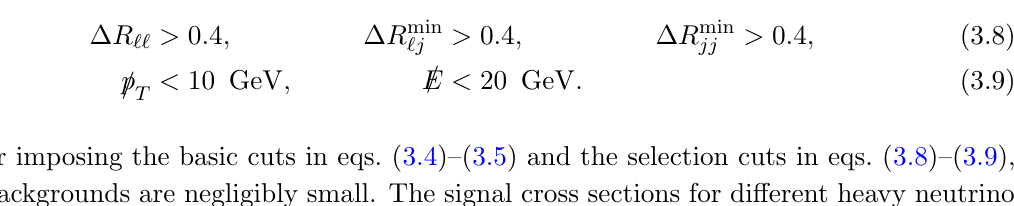
Figure 5 . Normalized distributions (cid:27) (cid:0) 1 d (cid:27)= d X for background channel e (cid:0) e + ! W + Z +4 j; W + ! (cid:22) + + (cid:23) (cid:22) ; Z ! (cid:22) (cid:0) (cid:22) + at the CEPC for the missing transverse momentum =p momentum =p and missing total energy =E . The missing total energy is the c.m. energy 250 GeV L minus the sum of energies of all visible particles in the (cid:12)nal